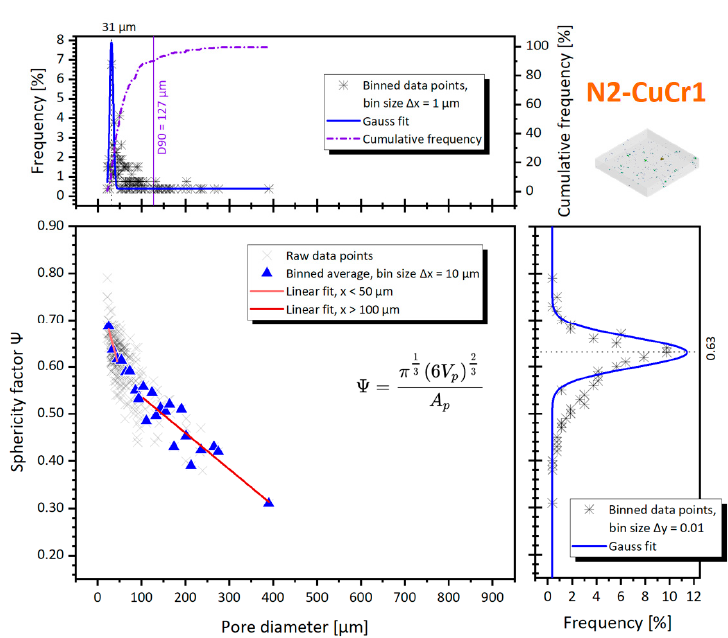
Figure 9. Pore diameter against the sphericity factor, for the N2-CuCr1 sample; inserts with percentage frequency distributions of both sphericity and diameter are included.